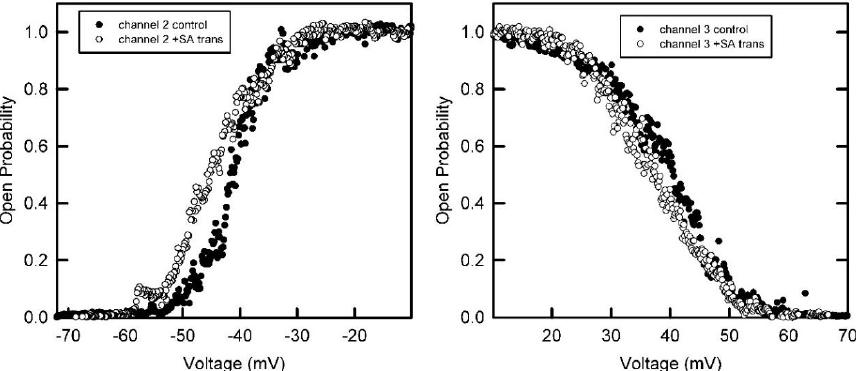
Figure 6. The voltage-dependence of the probability of subunits 2 and 3 being in the open state before and after treatment with succinic anhydride added only to the trans side of the membrane. The n value for subunit 2 dropped from 7.9 to 5.6, whereas for subunit 3 it did not change significantly (from 4.4 to 4.6).